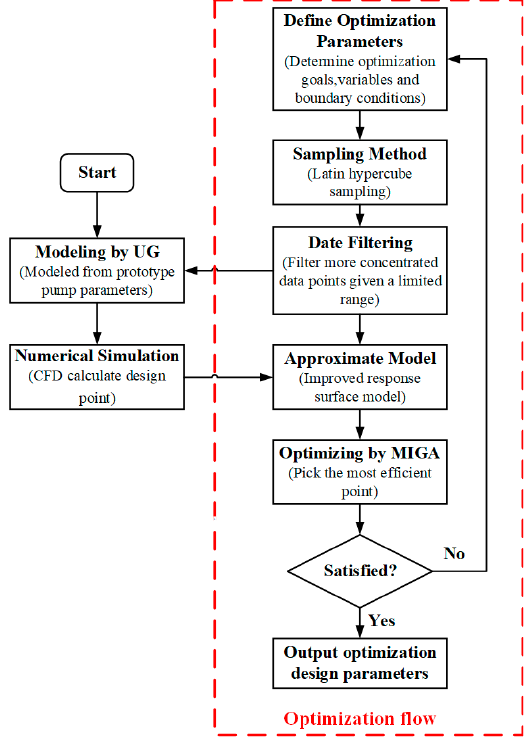
Figure 6. Optimization flow chart.